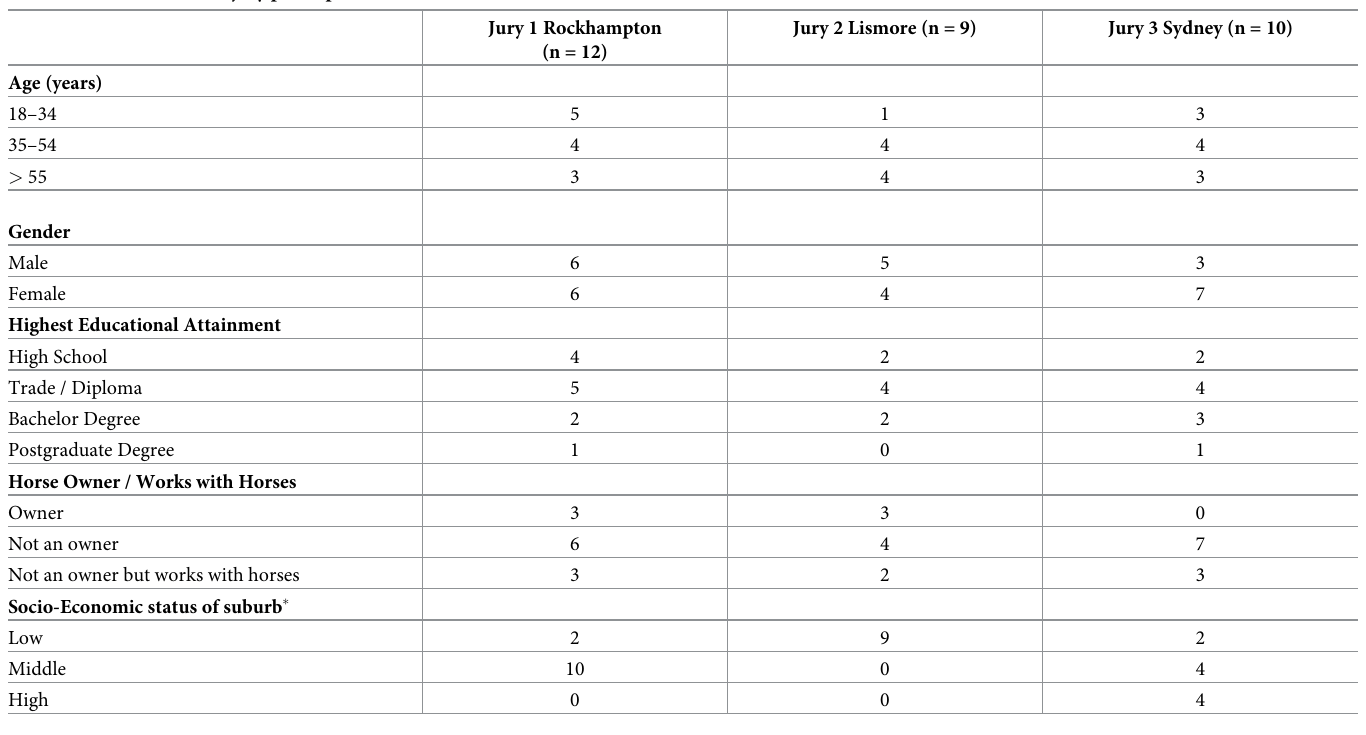
Table 1. Characteristics of jury